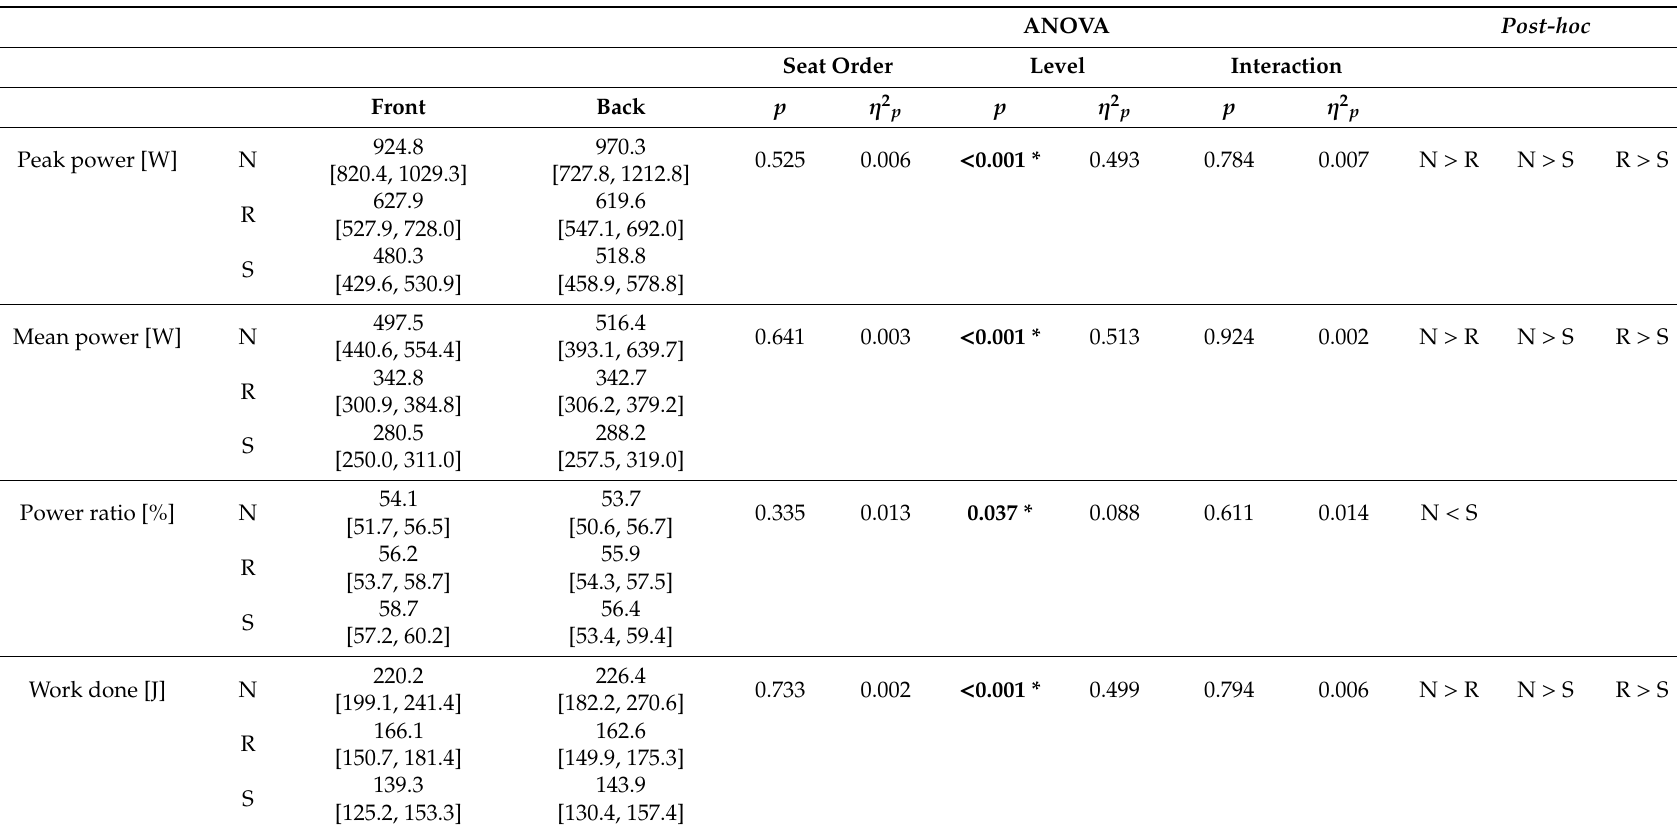
Table 3. Power variables of front and back paddlers of K2 crews boat during a 200-m maximal e ff ort sprint kayaking.